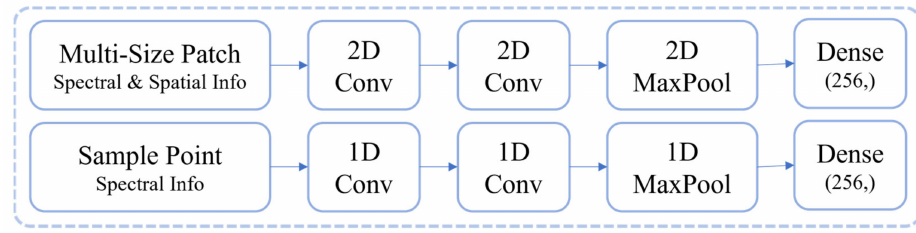
Figure 8. Structure of feature extraction